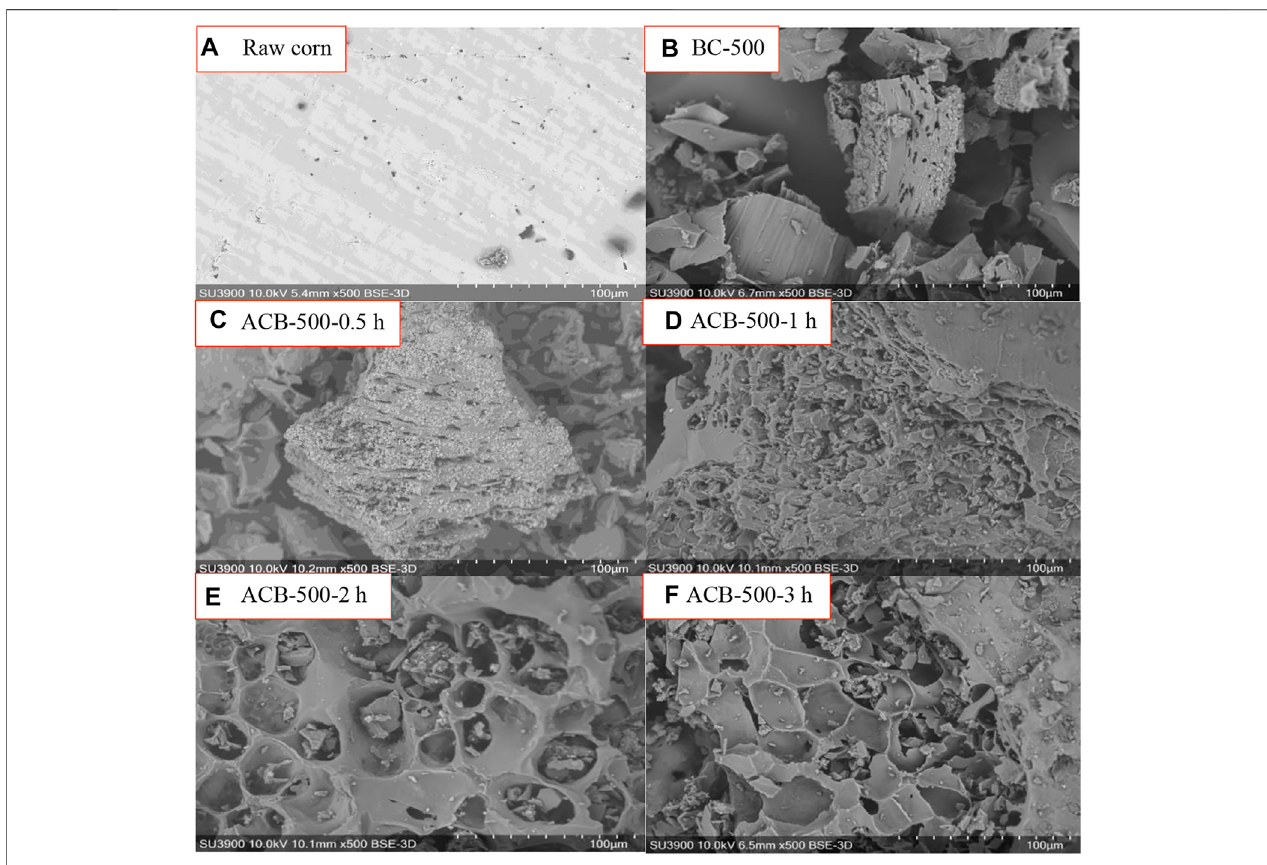
FIGURE4 | SEM images (500 magnitude)of (A) raw biomass, (B) bio-charat 500 ° C, activated bio-chars produced at 900 ° C with activation times of (C) 0.5, (D) 1, (E) 2, and (F) 3 h.